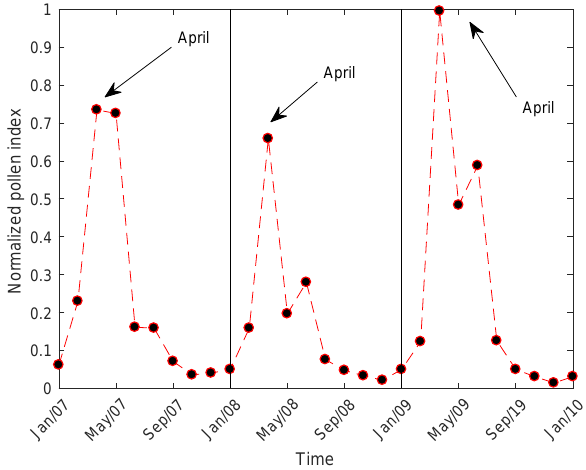
Figure 6. Annual pollen trends in Lisbon (Portugal) from 2007 to 2009.